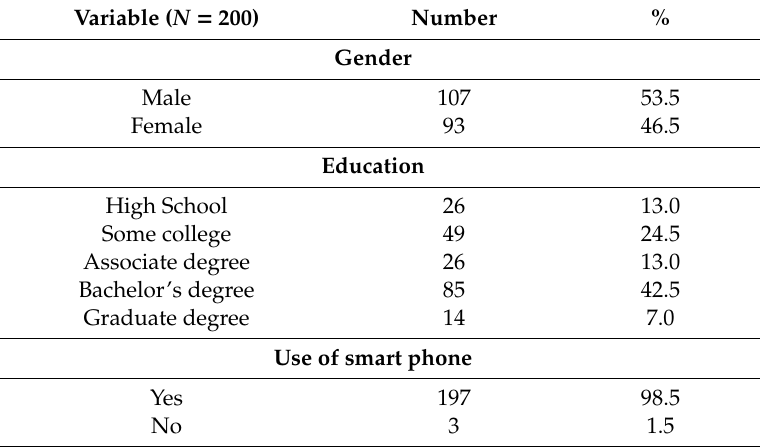
Table 1. Demographic